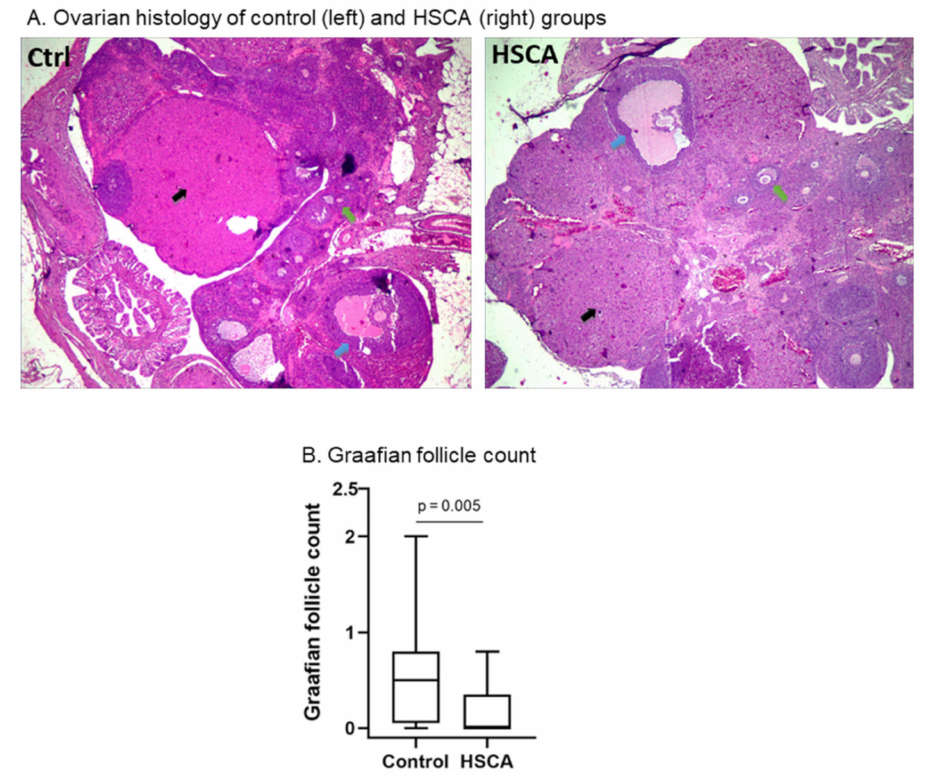
Figure 3. HSCA diet did not affect ovulation but deteriorated follicular maturation. Ovarian histology (magnification 40 × ) showed that corpus luteum (black arrow), tertiary (green arrow), and pre- ovulatory follicles (blue arrow) were presented in both groups ( A ). HSCA diet rats showed a reduced Graafian follicle count compared to control rats ( B ). Represented as median with minimum and maximum